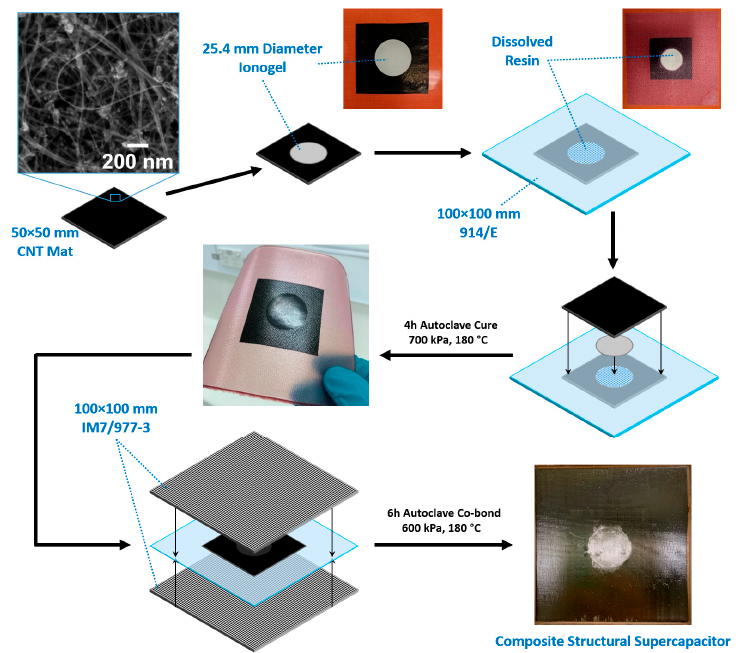
Figure 1. Typical fabrication sequence for structural supercapacitor (SSC), showing photos of localised SSC core layup with CNT mat electrode, with inset electron micrograph, and ionogel, glass fibre separator, and the final cured core and composite SSC with 25 mm electro-activated region in the centre.